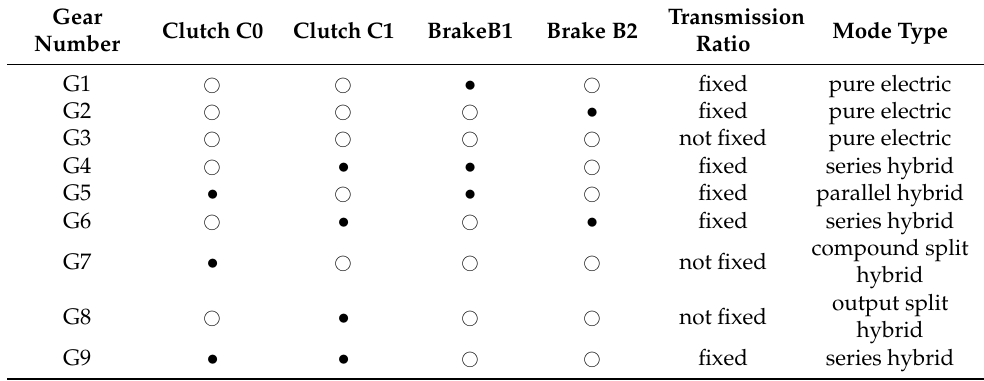
Table 2. The key parameters of the vehicle components.